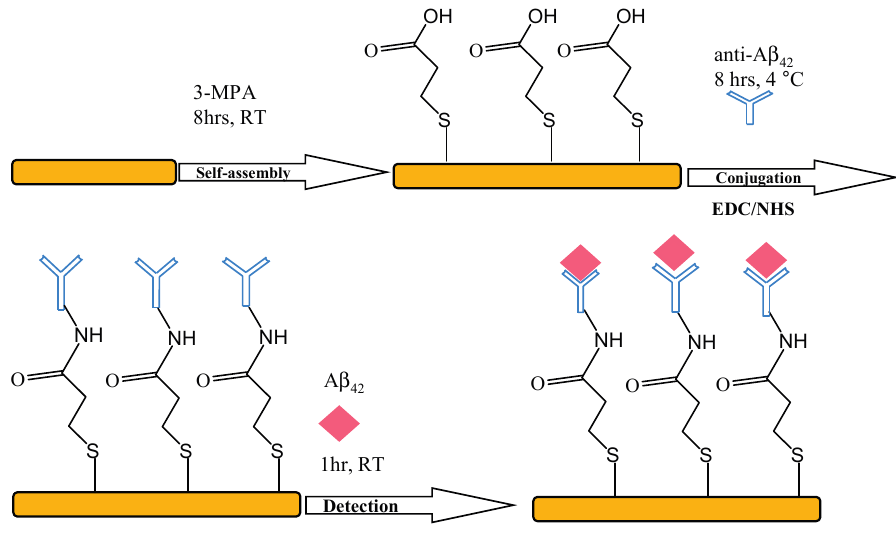
Figure 3. Schematic representation of the immobilization process for A β 42 antibody and detection of A β 42